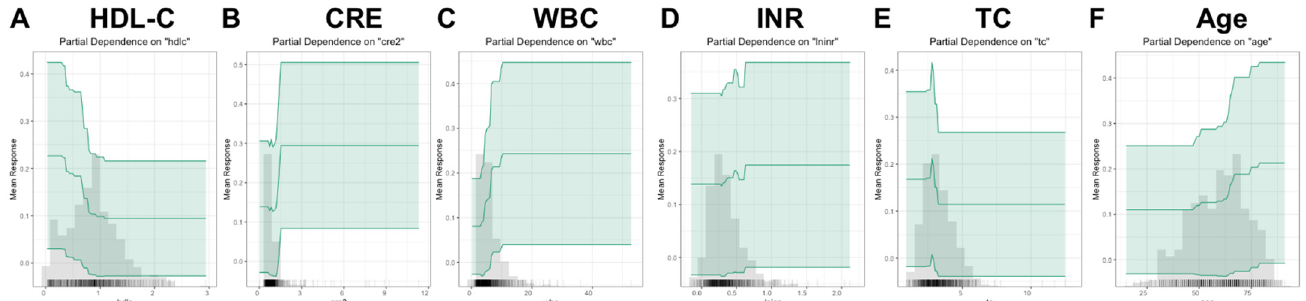
Figure 3. SHAP plotting of the XGBoost model. The closer the variable value is to 1.5 at the x -axis, the higher the possibility of mortality at 30-day. Abbreviations: wbc, white blood cell count; hdlc, high-density lipoprotein cholesterol; tc, total cholesterol; cre2, creatinine; pt, prothrombin time; ldlc, low-density lipoprotein cholesterol; na, blood sodium; pre-alb, pre-albumin; alb, albumin; SHAP, SHapley additive explanation.